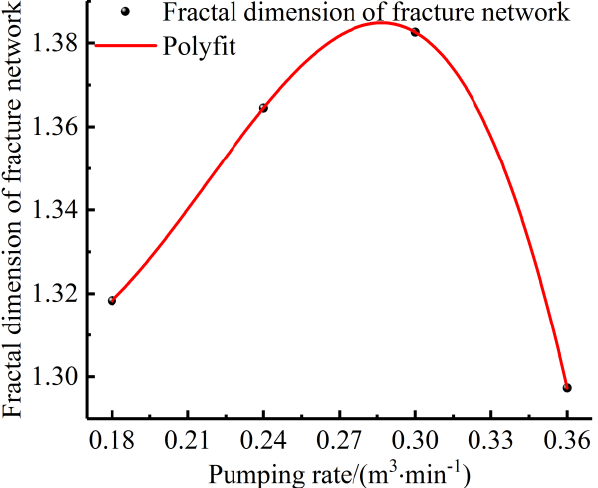
Figure 17. Variation curve of the fractal dimensions of segmental hydraulic fractures in CBM reservoirs under various pumping displacements of fracturing fluids.